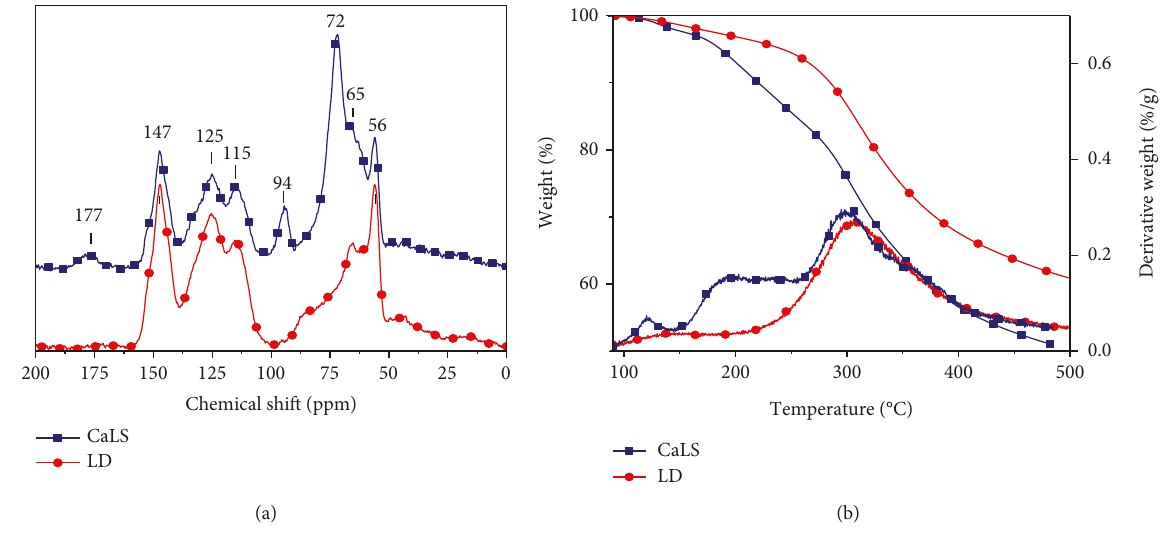
Figure 1: (a) 13 C CP MAS-NMR spectra of CaLS and LD. (b) TGA and DTG curves of CaLS and LD. Table 2: Thermal data of CaLS and LD measured through TGA. Sample T ( ° C) 5 %